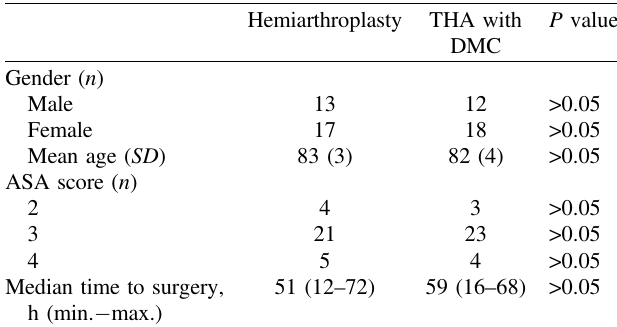
Table 1. Demographics data.